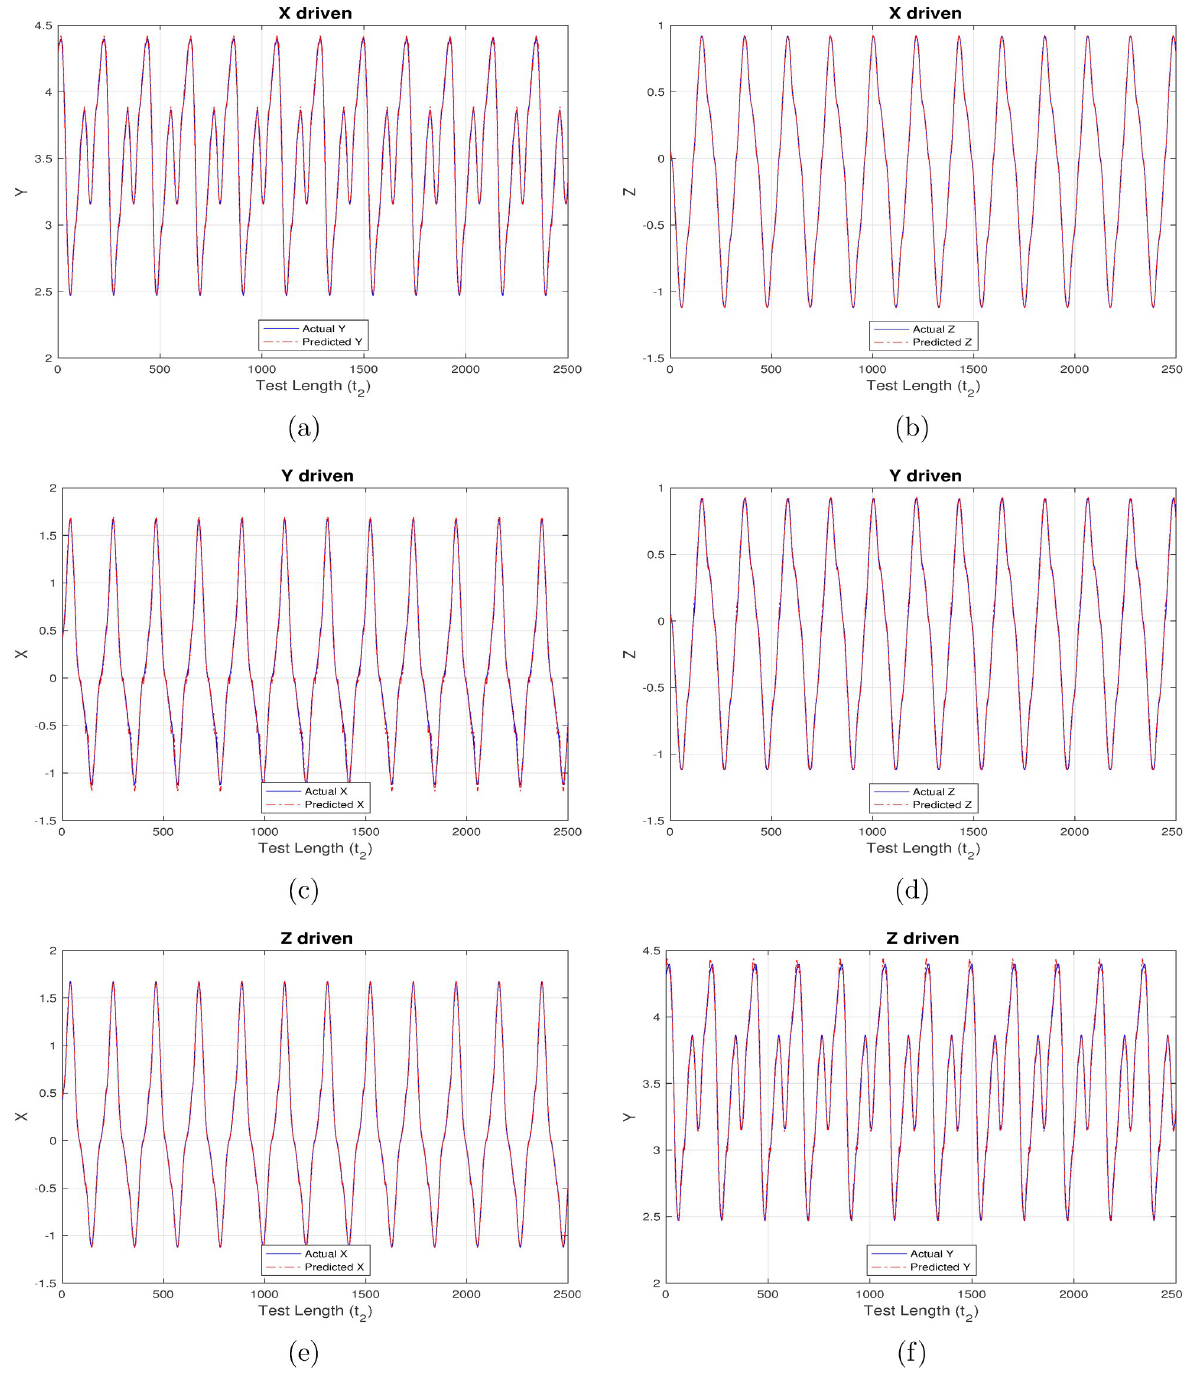
Fig 10. Controlled (time-delayed feedback) financial system component re-generation using “quadratic” activation. (a) Re-generating “investment demand” [Y] behavior with “interest rate” [X] as input (b) Re-generating “price index” [Z] behavior with “interest rate” [X] as input (c) Re-generating “interest rate”[X] behavior with “investment demand”[Y] as input (d) Re-generating “price index” [Z] behavior with “investment demand” [Y] as input (e) Re-generating “interest rate” [X] behavior with “price index” [Z] as input (f) Re-generating “investment demand” [Y] behavior with “price index” [Z] as